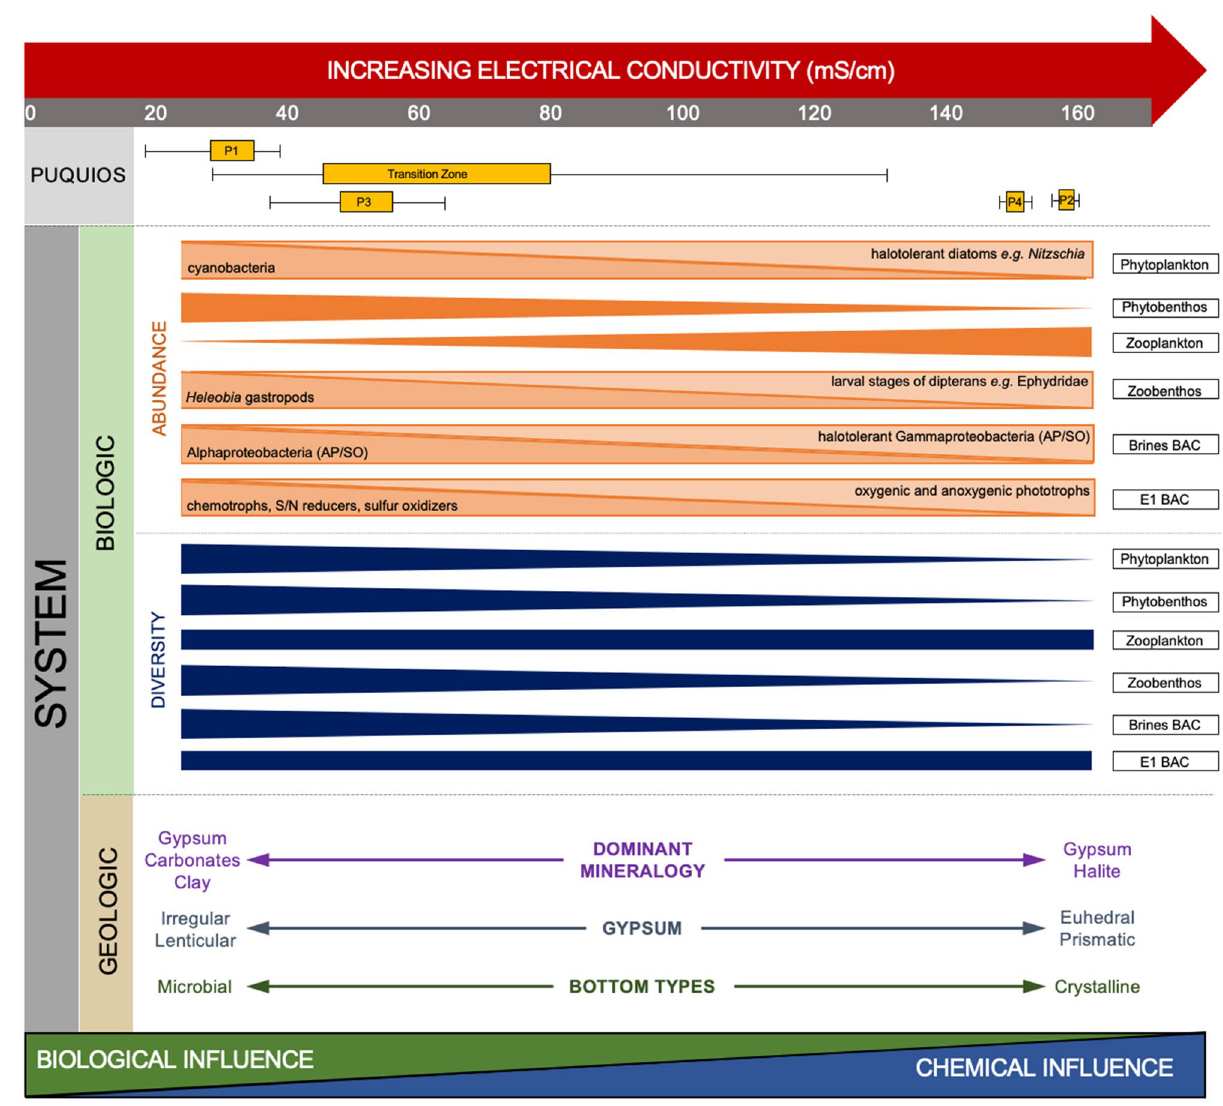
Figure 7. Summary diagram showing a conceptual framework of the trends observed in the biologic and geologic components of the Puquio system across an increasing gradient in electrical conductivity. Brine BAC refers to bacterial communities in the brines. E1 BAC refers to bacterial communities in the E1 layer. Thickness of diversity and abundance bars indicate general trends as supported in Figs. 3, 4 and Supplementary Figs. S2– S4. In cases where total abundance showed no apparent relation with EC (e.g. Phytoplankton, Zoobenthos, Brines BAC, and E1 BAC), the bars were subdivided to highlight the effect of EC on individual functional groups. AP anoxygenic phototrophs, SO sulfur oxidizers, S sulfate, N nitrate. Figure was created in Microsoft PowerPoint for Mac v16.48. https:// www. micro soft. com/ en- us/ micro soft- 365/ power